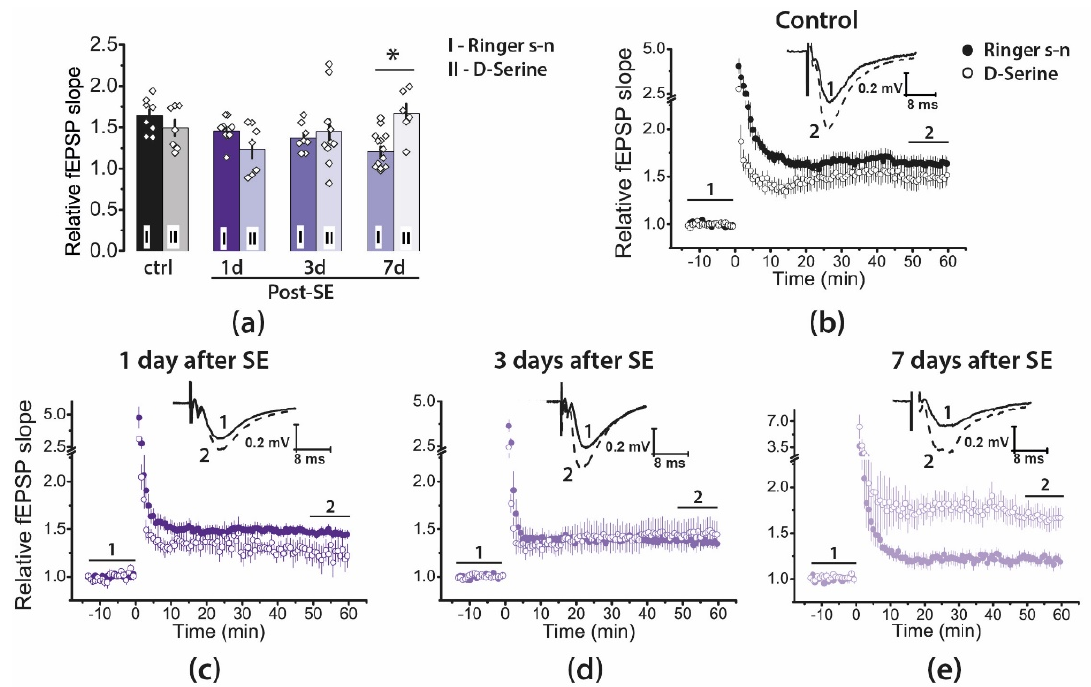
Figure 6. D-serine, a coagonist of NMDARs, enhances LTP in the 7d post-SE group. ( a ) Diagrams illustrating the magnitude of plasticity in the control and experimental groups in the presence of D-serine. Between 7 and 10 animals were in each group. One or two brain slices were used from one animal. The diamonds show the individual values for each slice. Two-way ANOVA following Tukey’s post hoc tests was used. For simplicity, only the effect of D-serine is marked in the figure: * p < 0.05. ( b – e ) The normalized fEPSP slopes in the control and post-SE groups in Ringer’s solution and the presence of D-serine (10 μ M) before and after HFS. Representative examples of fEPSP in presence of D-serine were recorded before induction (1) and 50–60 min after HFS (2).